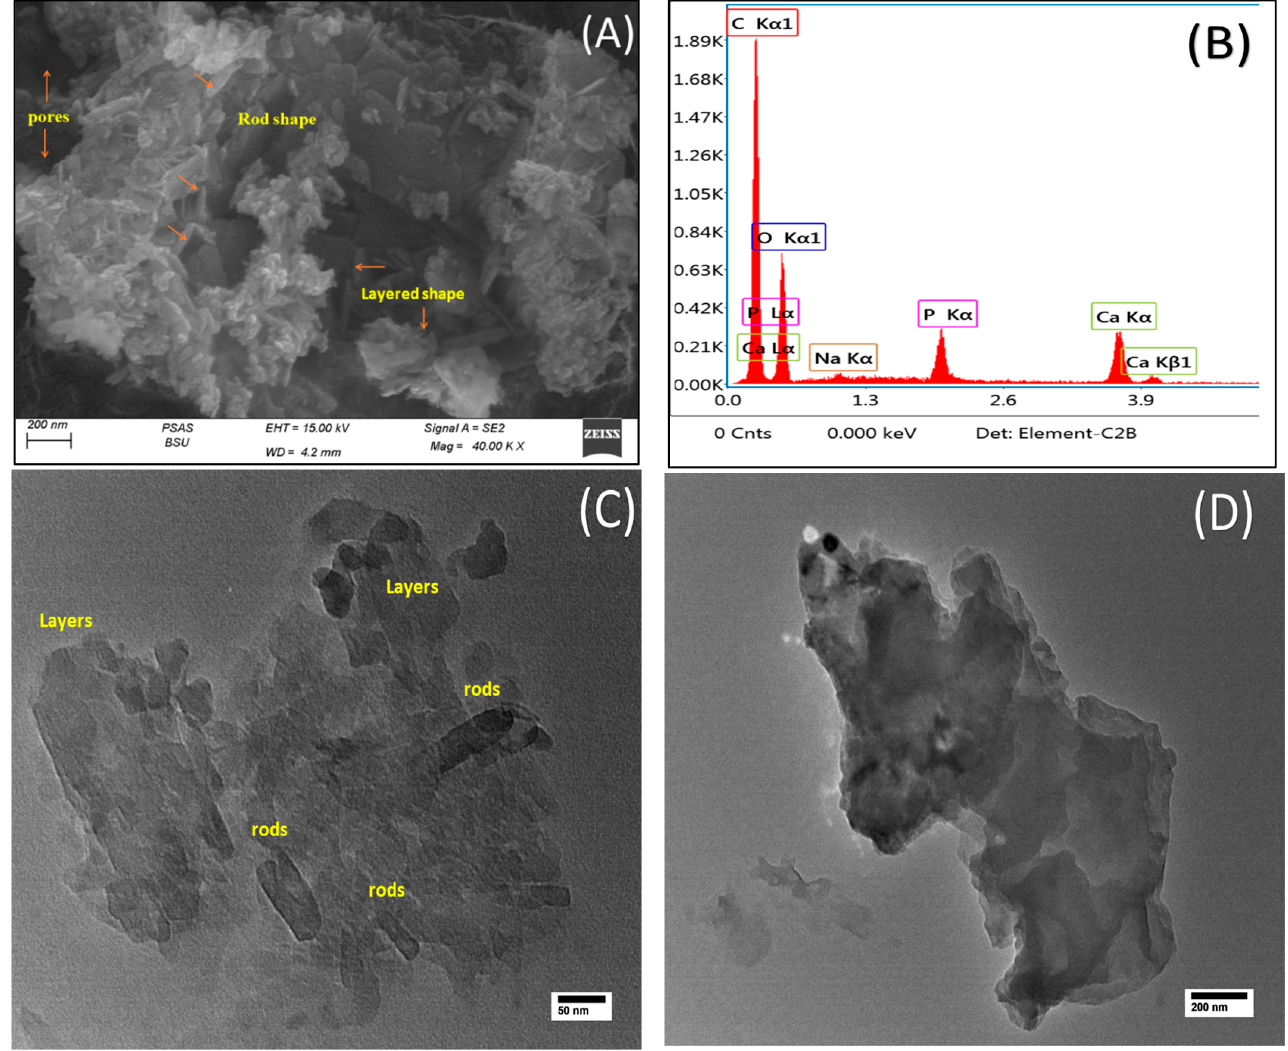
Figure 2. ( A ) SEM; ( B ) EDX; ( C ) and ( D ) TEM images of nano-HAP/Vit B 12 .